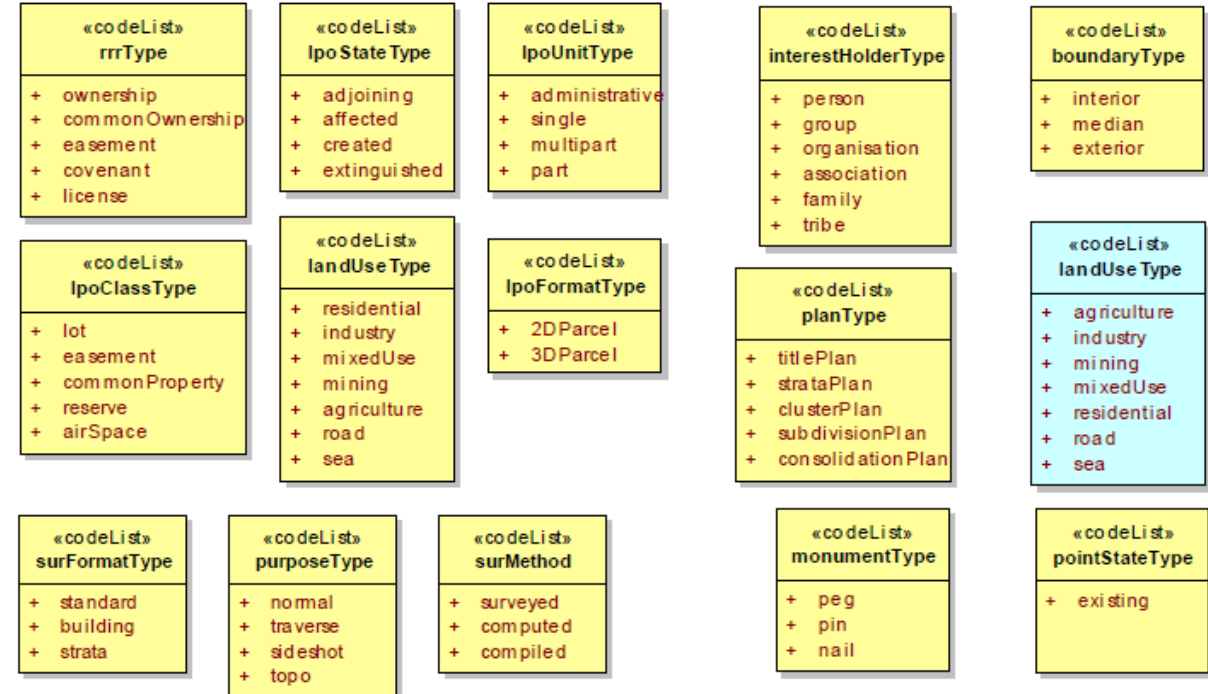
Figure 24. Code lists of the 3DCDM